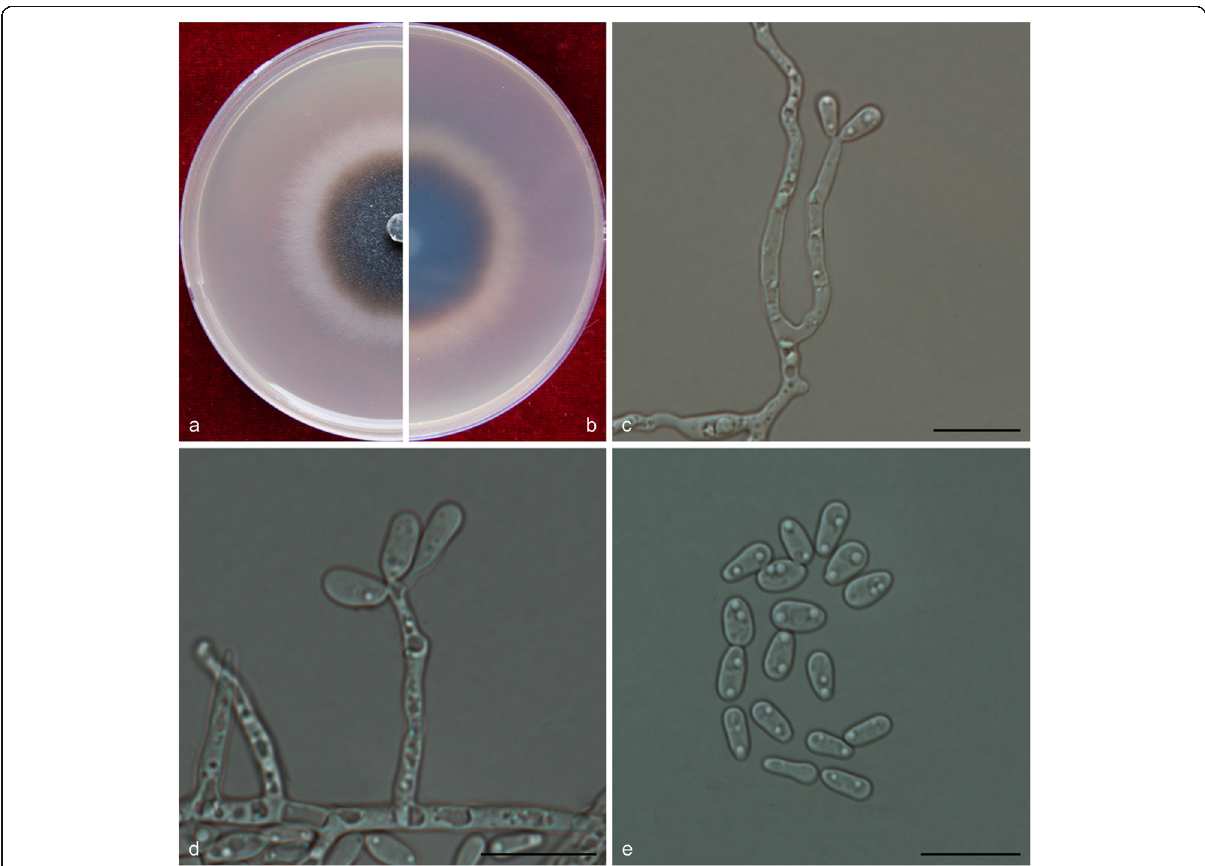
Fig. 13 Morphological characteristics of Ophiostoma hongxingense sp. nov. (CFCC 52695, Taxon 2). a – b. Five-day-old cultures on 2% MEA; c – e. Hyalorhinocladiella-like asexual morph: conidiogenous cells and conidia. Scale bars: c – e = 10 μ